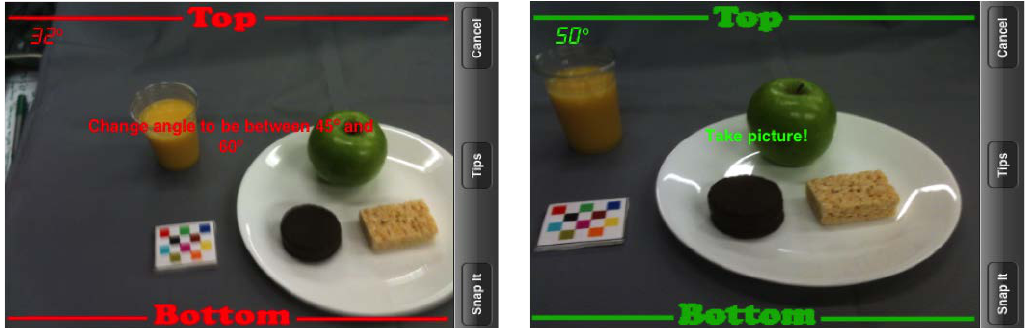
Figure 2. Field of view colored borders that appear when in camera settings of the TADA app to aid with proper angle. A red border (image on left) indicates the camera is not at the correct angle. Children from Samples 1 and 2 were to capture the image when the border was green (image on right). Note the fiducial marker (FM) is the color checkerboard seen of the left of the